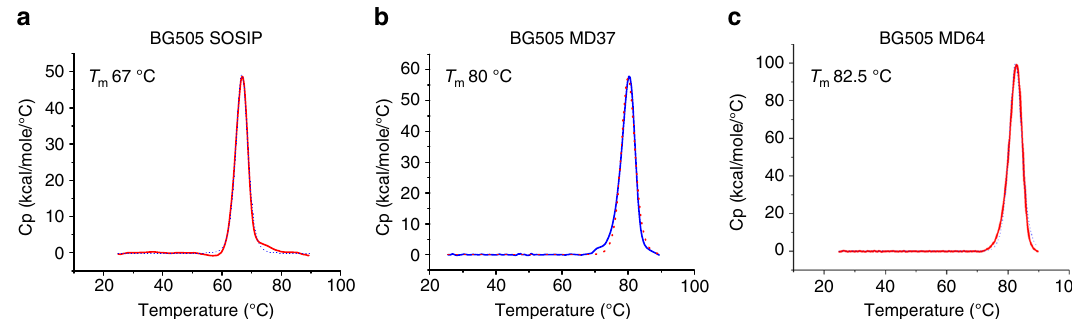
Fig. 4 Thermostability of BG505 variants SOSIP, MD37 and MD64. a Differential Scanning Calorimetry (DSC) pro fi le for BG505 SOSIP, the raw data are shown as a solid line and fi t is shown as a dashed line. Melting Temperature ( T m ) values from the fi t are shown. b DSC pro fi le for BG505 MD37 c DSC pro fi le for BG505 MD64. The data are from